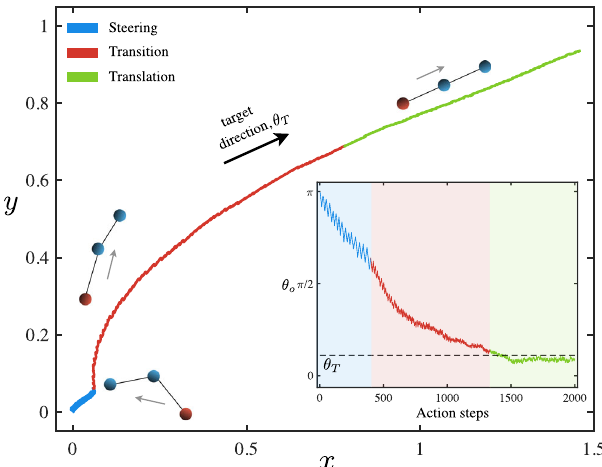
Fig. 2 Example of target navigation utilizing three distinct locomotory gaits. The Arti fi cial Intelligence powered swimmer switches between distinct locomotory gaits (steering, transition, translation) advised by the reinforcement learning algorithm to steer itself towards a speci fi ed target direction θ T (black arrow) and swim along the target direction afterwards. Different parts of the swimmer's trajectory are colored to represent the locomotion due to different locomotory gaits, where the steering, transition, and translation gaits are marked as blue, red, green, respectively. Schematics of the swimmer con fi gurations (not-to-scale) are shown for illustrative purpose, where the leftmost sphere is marked as red and other two spheres marked as blue to indicate the swimmer's current orientation (gray arrows). The inset shows the change in swimmer's orientation θ o over action steps. An animation of this simulation is shown in Supplemental Movie